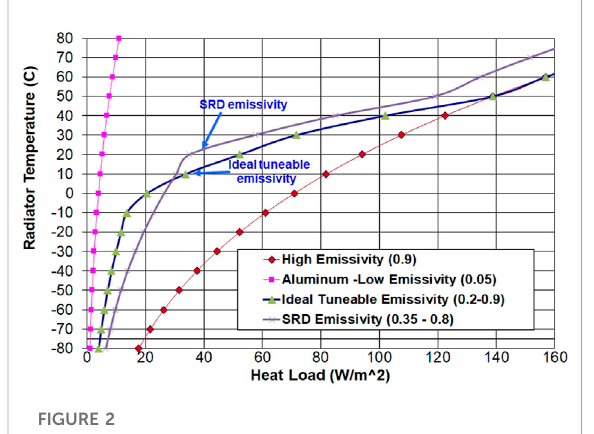
FIGURE 2 Emissivity effect on the radiator temperature due to the heat loadReducingtheneedtoheatthepayloadtolowerTemperature.